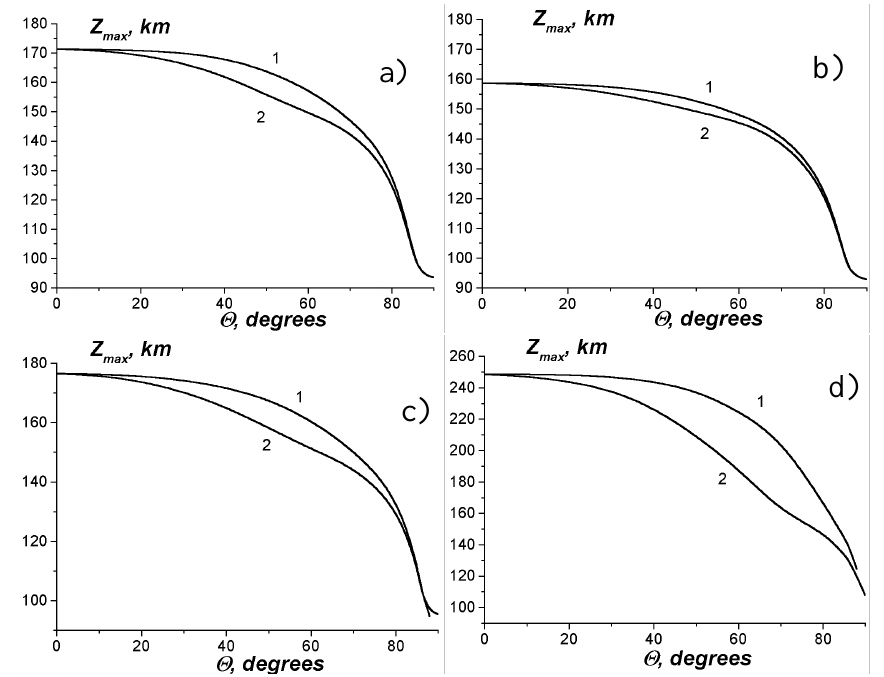
Fig. 7. Dependencies of the penetration heights of the components H x,y of the Schumann resonance on the inclination angle 2 of the geomagnetic field. Part (a) is for the daytime (normal solar activity); (b) is for daytime (maximum solar activity); (c) is for the daytime (minimum solar activity); (d) is for the nighttime. Curve 1 is the penetration height for H x component; curve 2 is the penetration height for H y . For the daytime, the penetration height for the E z component is 56km. For the nighttime, it is 71km.